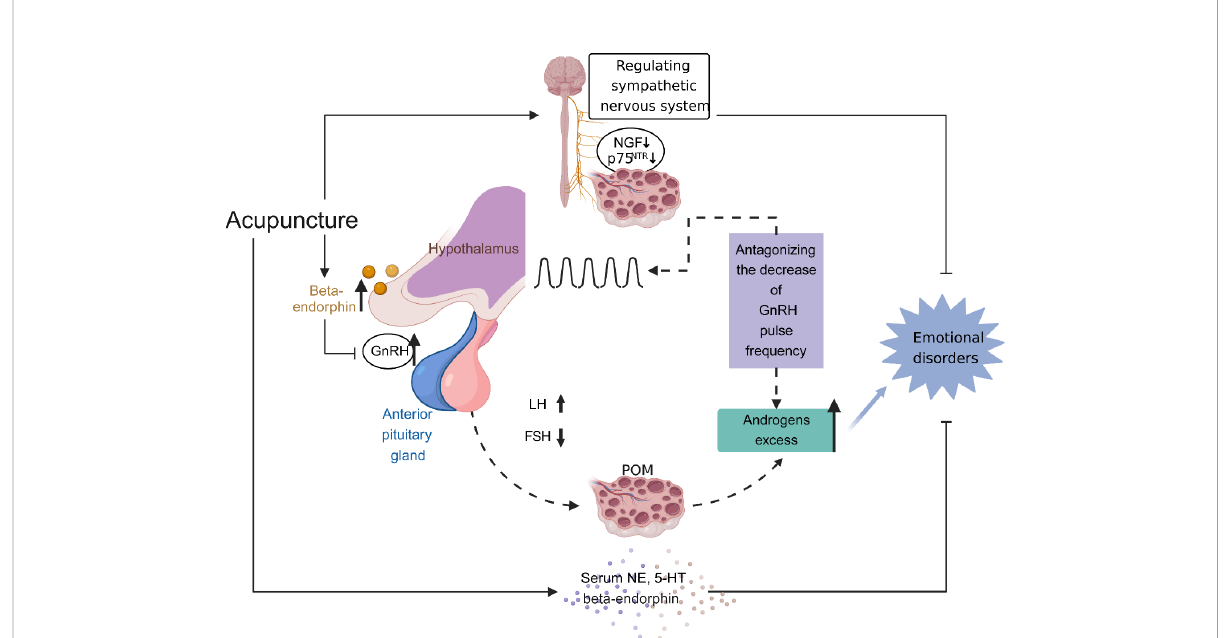
FIGURE 4 The effect of acupuncture on restoration of the hypothalamic-pituitary-ovarian (HPO) axis and amelioration of emotional disorders. Increased activity and secretion of gonadotropin-releasing hormone (GnRH) with persistently high pulse frequency causes elevated levels of luteinizing hormone (LH) and follicle-stimulating hormone (FSH), contributing to the polycystic ovarian pathology (including impaired follicular development and excess androgen production). Elevated ovarian androgen antagonizes the ability of the progesterone to descend GnRH pulse frequency, leading to a proposed vicious cycle in the HPO axis in polycystic ovary syndrome (PCOS). Meanwhile, androgen excess has an effect on emotion disorders of women with PCOS. Acupuncture modulates central and peripheral b ‐ endorphin production and secretion, in fl uencing the release of GnRH, then normalising the ratio of LH and FSH, and eventually normalising the HPO axis. Moreover, acupuncture ameliorates emotion disorders of women with PCOS through regulating serum norepinephrine, 5-hydroxytryptamine and b ‐ endorphin levels, balancing autonomic nervous system, and inhibiting the concentrations of nerve growth factor and the expression of p75 neurotrophin receptor in